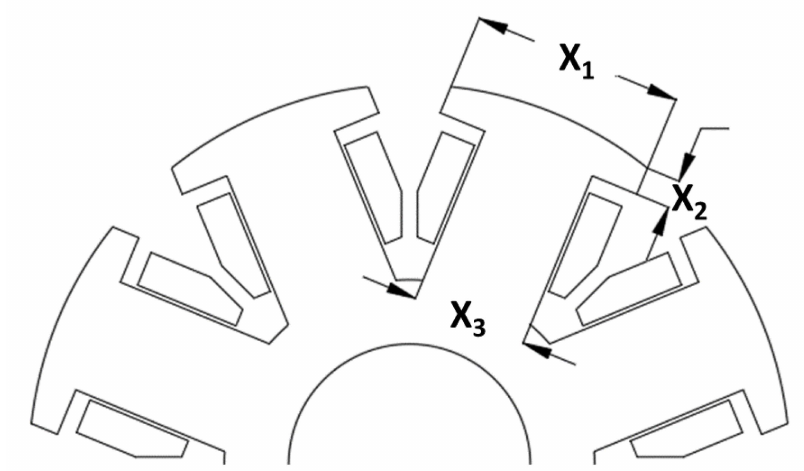
Figure 7. The pole structure of the rotor and its design variables (basic model).